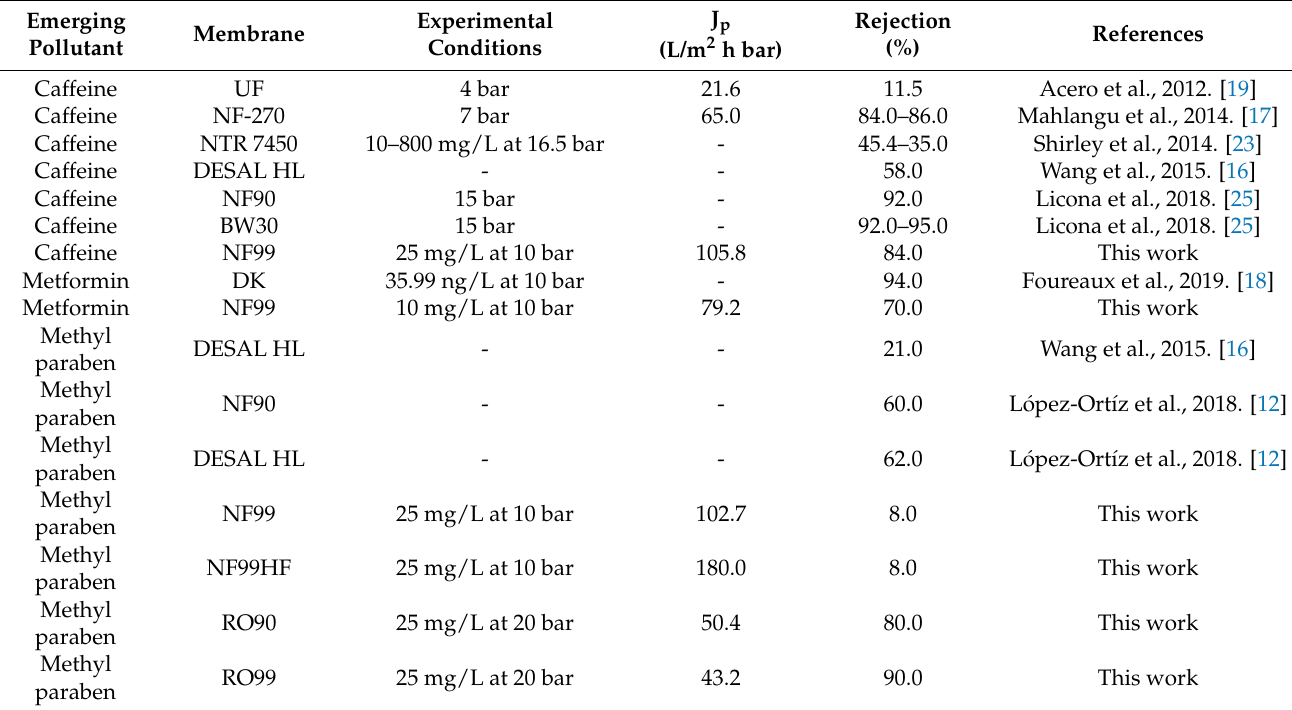
Table 4. Comparison of the removal of emerging pollutants between previous studies and this study in terms of water flux and